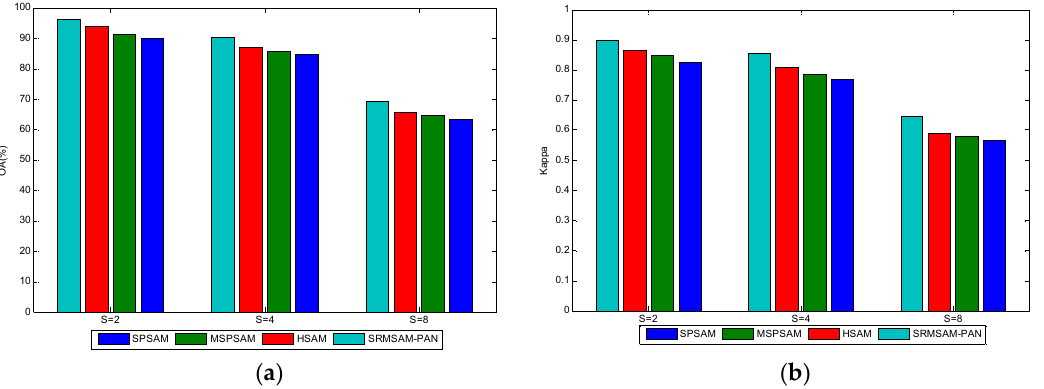
Figure 14. ( a ) OA (%) of the four methods in relation to the zoom factor S . ( b ) Kappa of the four methods in relation to the zoom factor S .